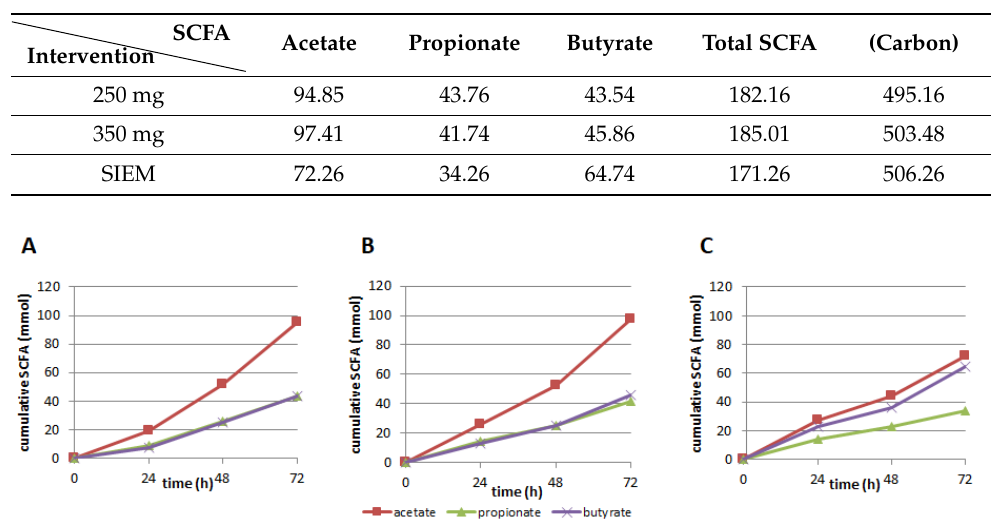
Figure 6. Cumulative production (mmol) of the branched-chain fatty acids (BCFA) iso-butyrate and iso-valerate at 24 h, 48 h, and 72 h after supplementation with 250 mg (yellow) or 350 mg (orange) Citrus Fruit Extract or control (standard ileal efflux medium (SIEM; blue)). Production of lactate, a precursor for propionate, was increased by nearly 100% after 72 h of 350 mg CFE supplementation, compared to control. A similar pattern was observed for valerate production, with a >300% increase after addition of 350 mg/day CFE and an 85% increase after addition of 250 mg/day CFE. Iso-valerate and iso-butyrate production was increased by both concentrations of CFE, while formate, a substrate for acetate production via the Wood-Ljundahl pathway, was decreased. Succinate and caproate production were decreased after 250 mg/day CFE supplementation. Spearman correlations were performed between metabolite concentrations and specific operational taxonomic units (OTUs) at genus and species levels (Figures 7 and S4). Five butyrate-producing genera ( Dorea ; Figure 7, Anaerostipes , Coprococcus 3 ,